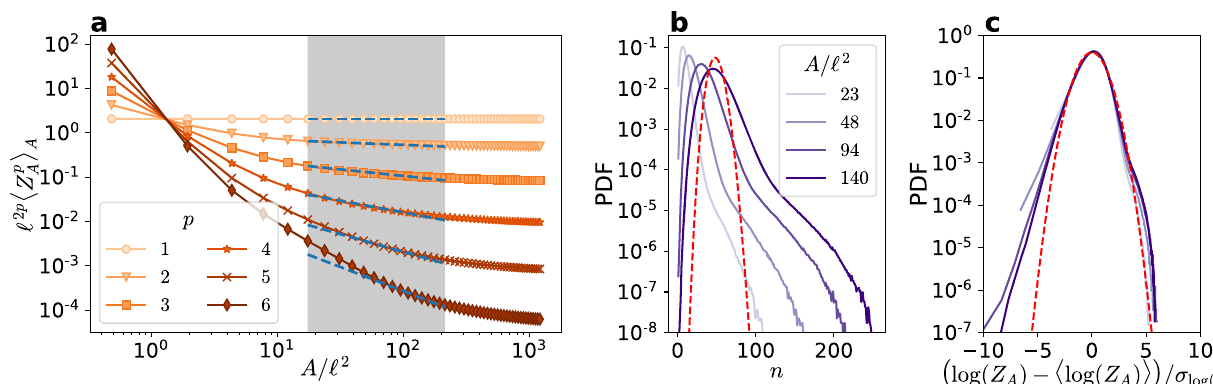
Fig. 5 Statistics of spatial vortex distribution in quantum turbulence. a Moments of the number of vortices normalised by the area that contains them, Z = n / A . Dashed lines correspond to the scaling of Eq. (7), using the She – Lévêque prediction 44 for the anomalous exponents τ ( p ) with D A the number of vortices contained in loops of varying area A / ℓ 2 . The dashed line corresponds to a Poisson distribution of mean equal to 〈 n 〉 A at A = 140 ℓ 2 . c Centred reduced PDFs of log ð Z A / ℓ 2 . A log-normal distribution is shown as reference (red dashed A Þ for different values of